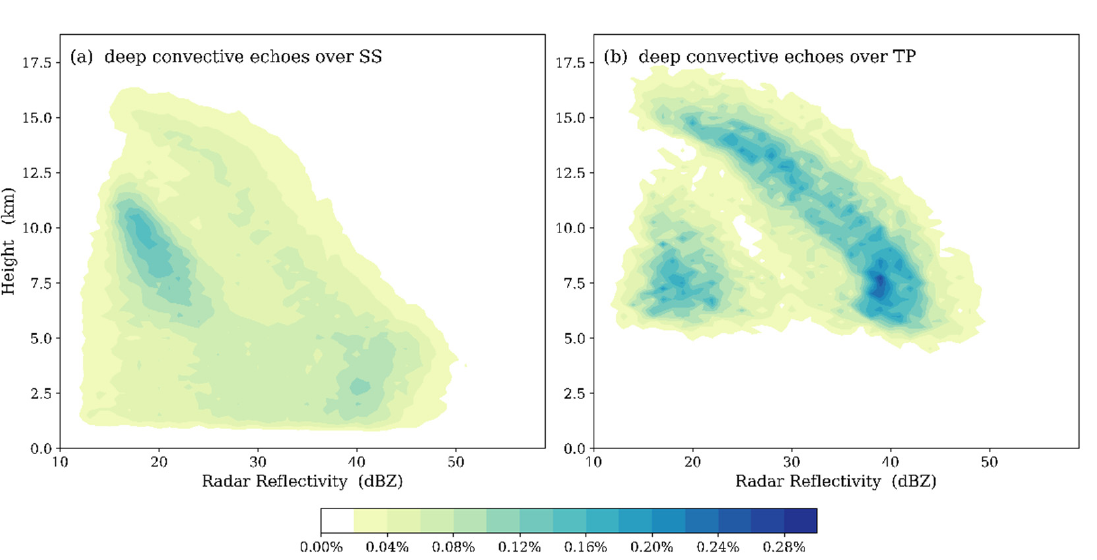
Figure 10. As Figure 2, but for deep convective echoes over the ( a ) south slope and ( b ) Tibetan